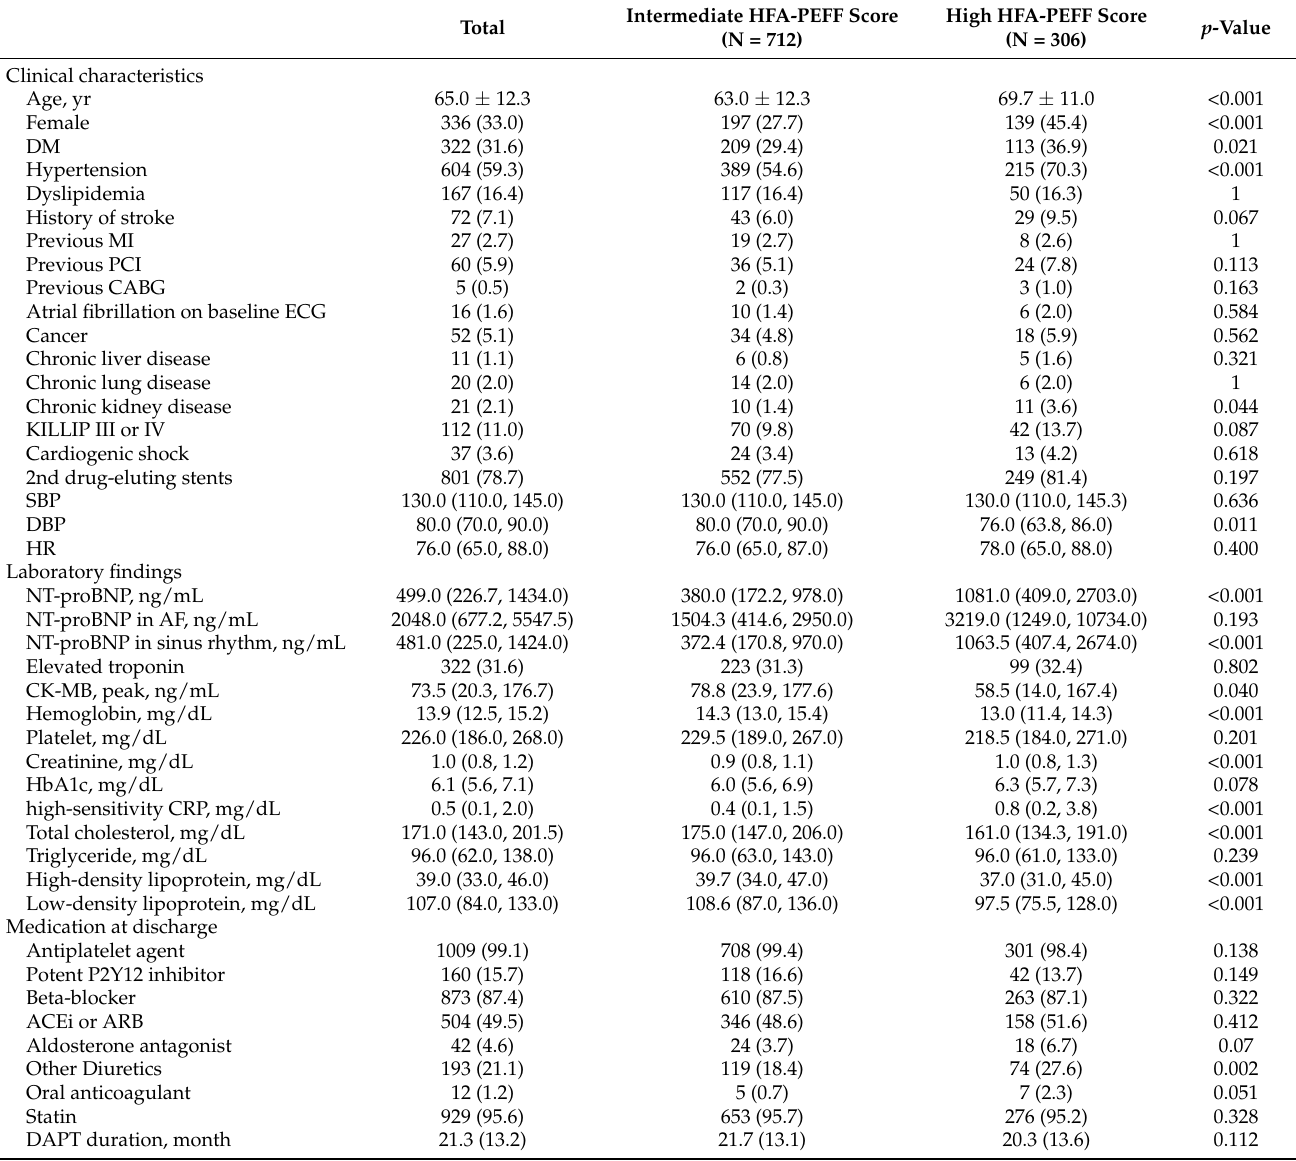
Table 1. Baseline